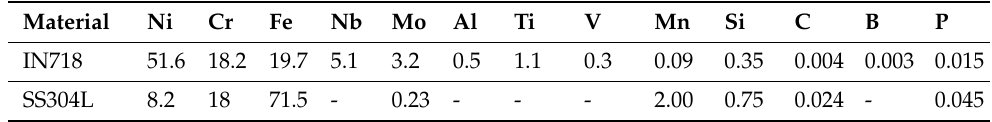
Table 1. Base material compositions of Inconel718 and SS304L.